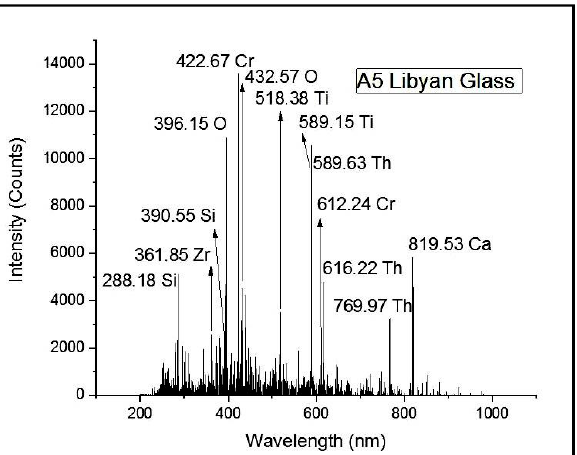
Figure 6. LIBS spectrum recorded from Sample A5. Reproduced from [28], with the permission of SPIE.